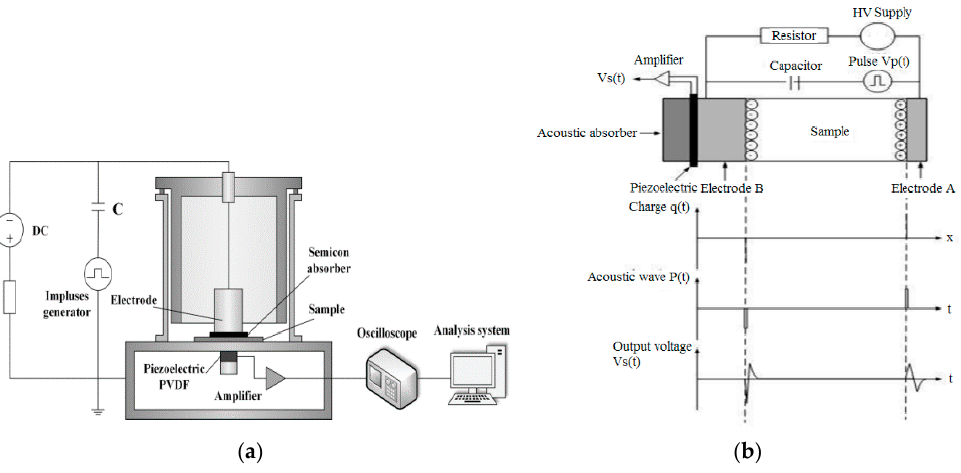
Figure 2. Schematic principle PEA method [36] ( a ) experiment setup; ( b ) PEA